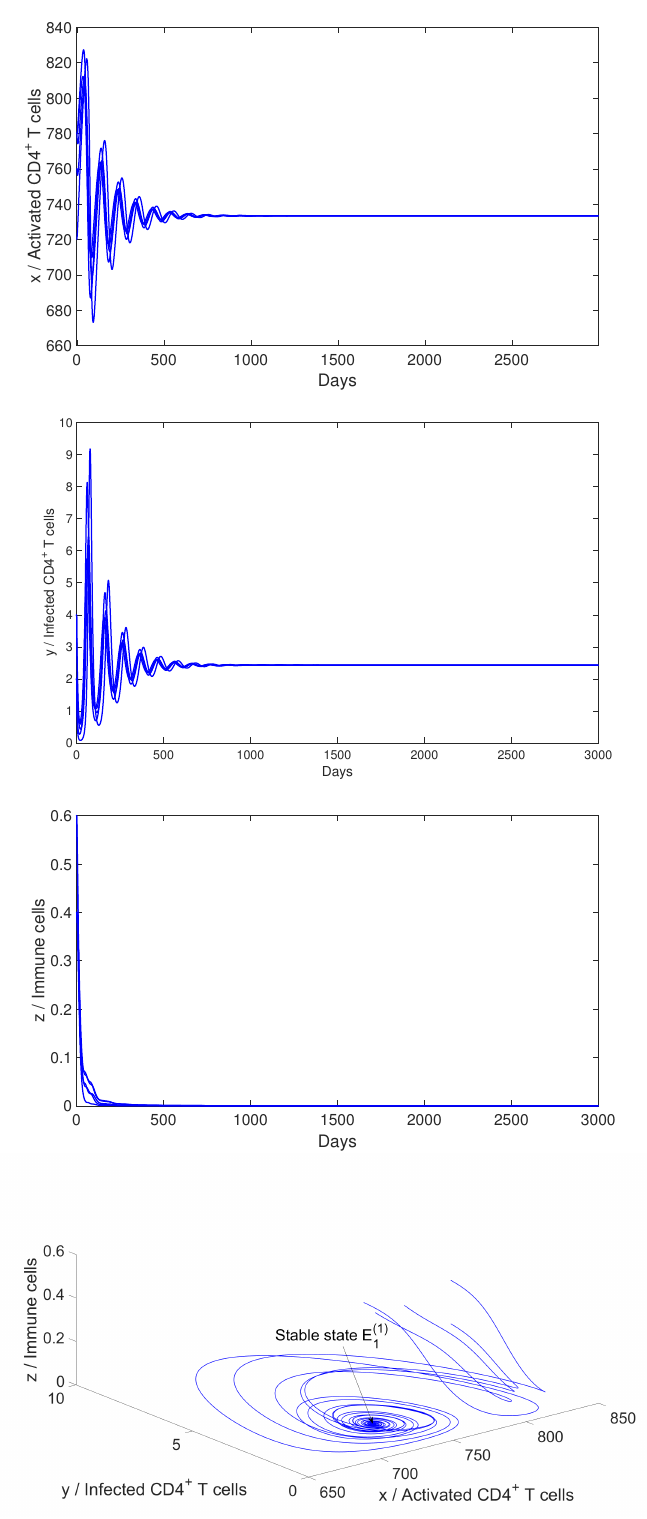
Figure 9. Time histories and trajectories of system (1) with different initial values for c = 0.7 day − 1 . ( 1 ) Only E is stable. Other parameter values are listed in Table 3 and α = 1